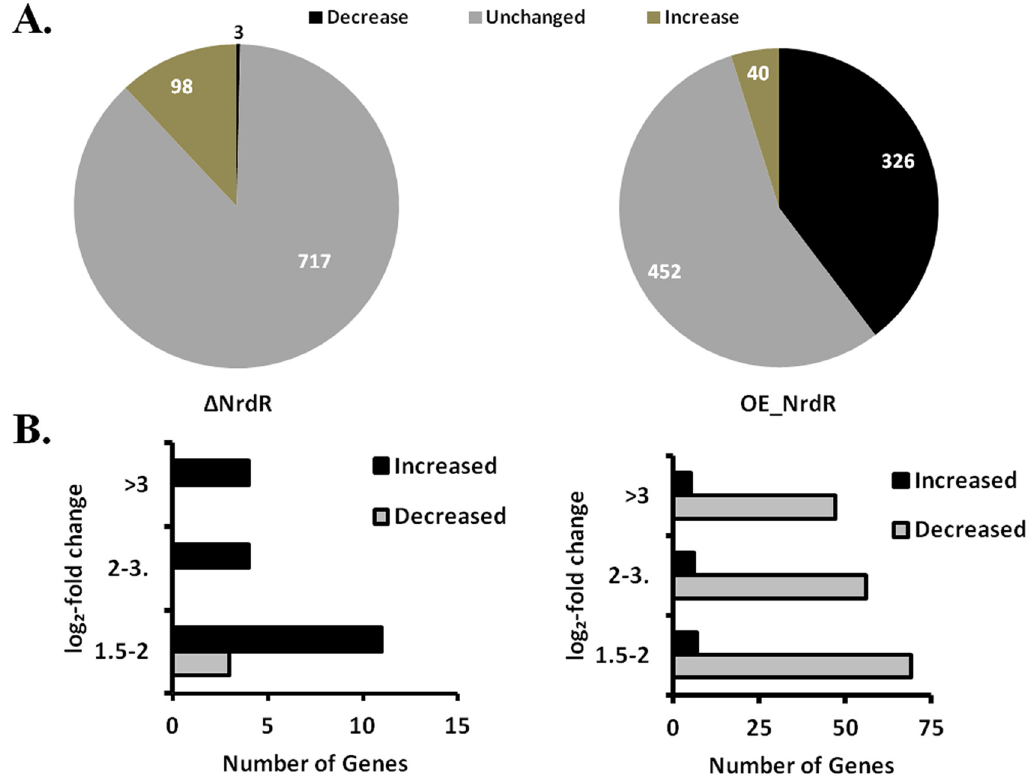
Fig 4. Proteomic response of E . coli to NrdR-deletion and -overexpression. (A) LC-MS/MS resulted in identification of 818 soluble proteins of sufficient abundance to evaluate across strains. The Δ NrdR strain had more upregulated proteins compared to the wild-type, while the OE-NrdR strain had a larger percentage of downregulated proteins. The number of proteins in each category is indicated. (B) Selective distribution of upregulated and downregulated proteins according to log 2 -fold change in the Δ NrdR (left panel) and OE-NrdR (right panel) mutants. X- axis represents the number of genes and Y-axis represents ranges of n-fold changes in protein